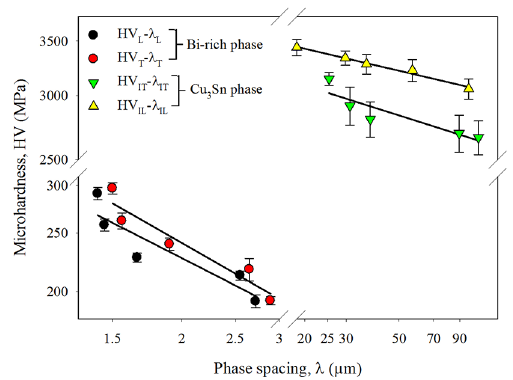
Figure 7. Variation of microhardness versus phase